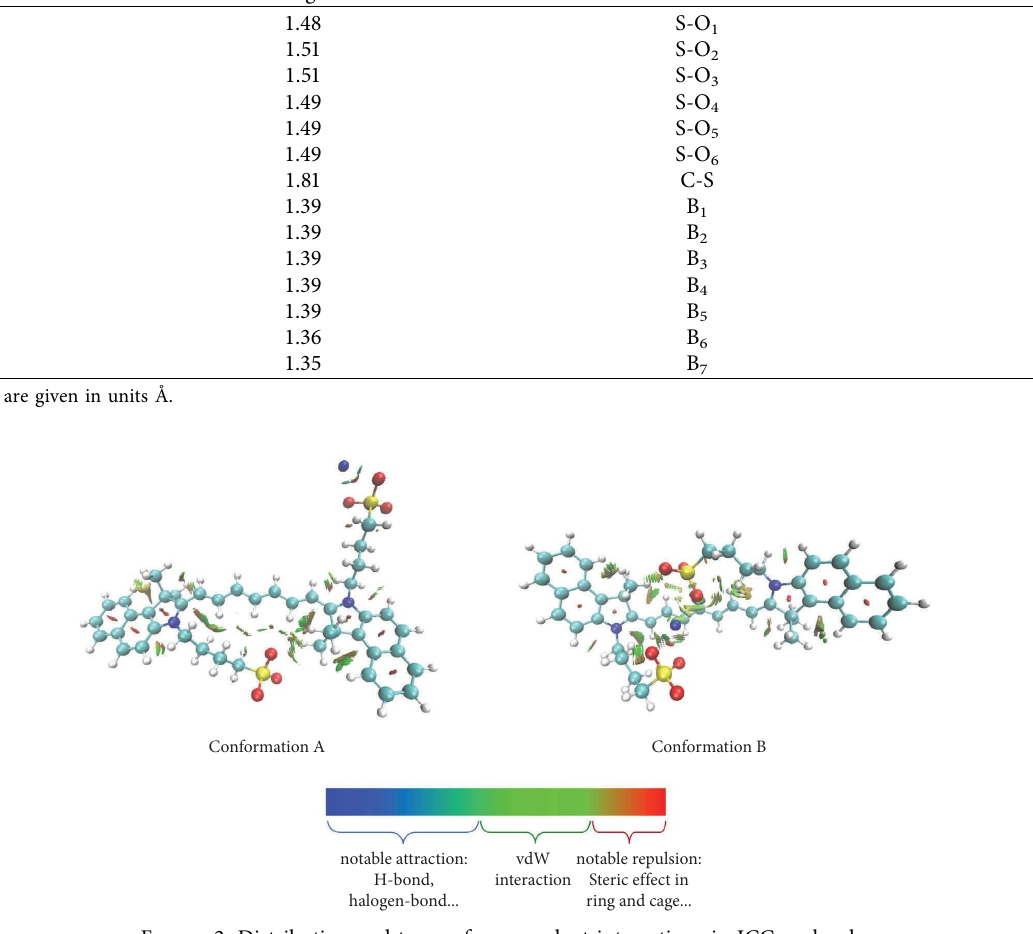
Figure 2: Distribution and types of noncovalent interactions in ICG molecule.